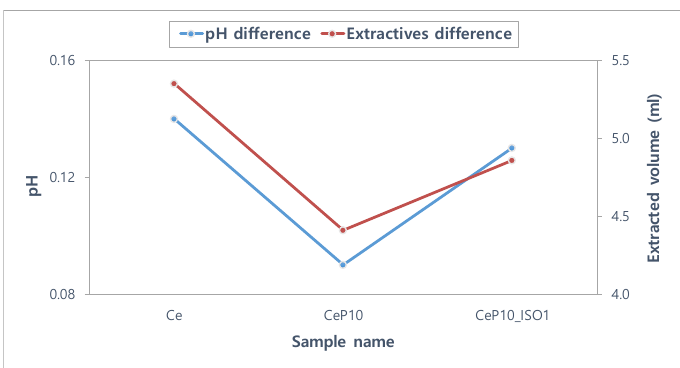
Figure 4. Absorbance values of the hydrated solutions for each sample.